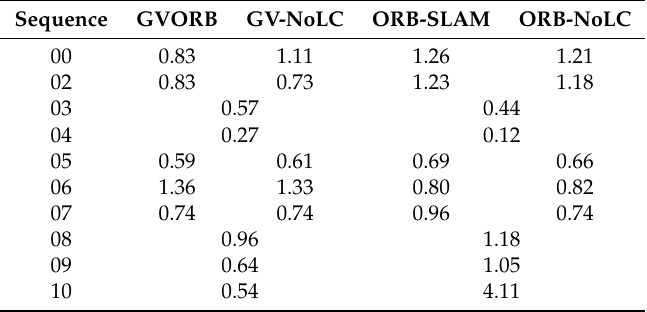
Table 4. Median root-mean-square error (RMSE) values of rotation estimation ( ◦